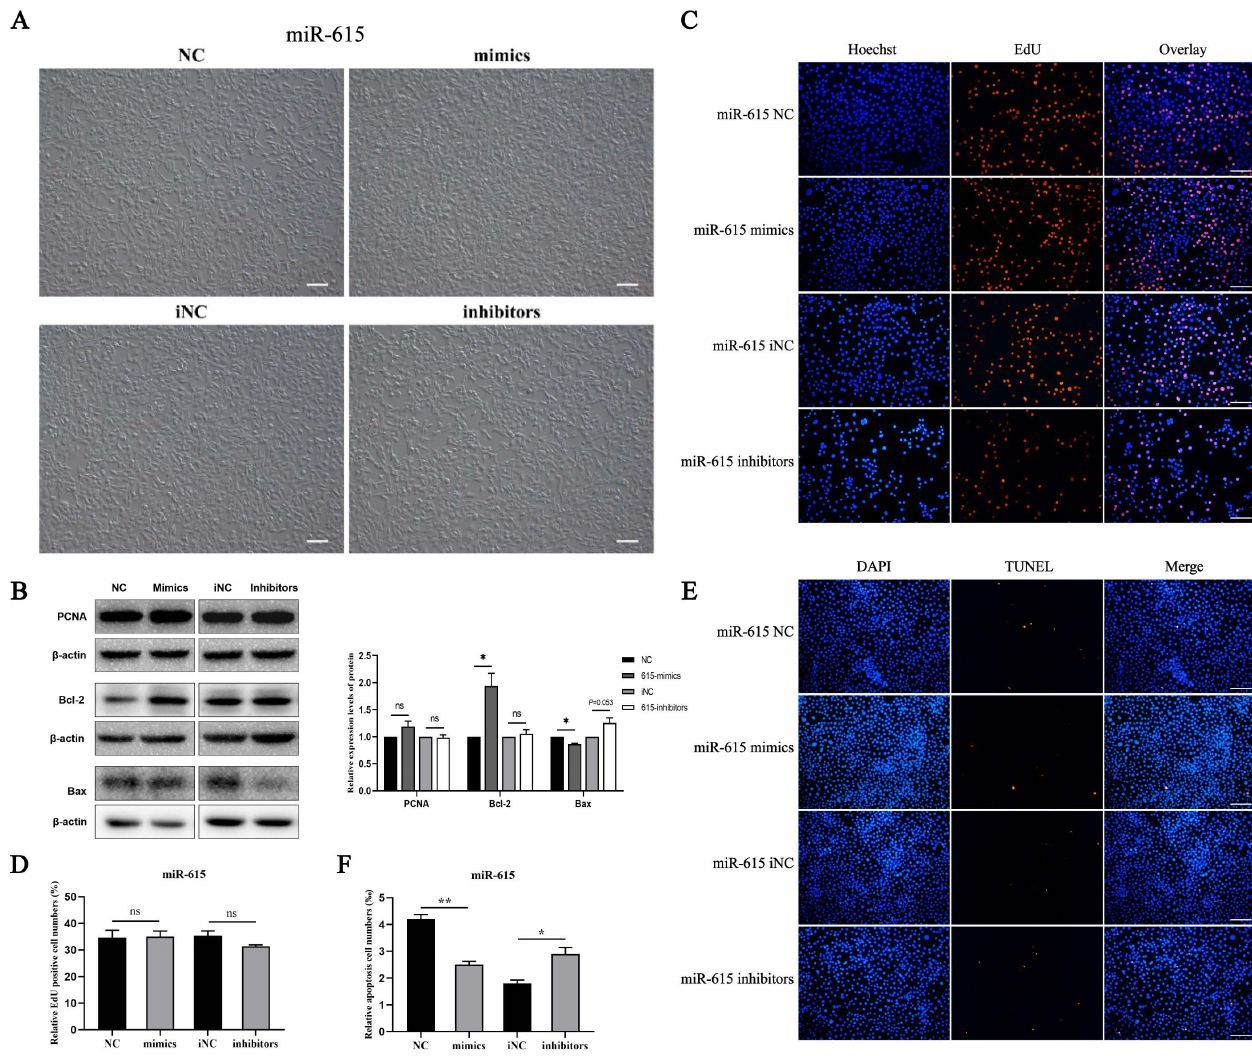
Figure 3. The effects of miR-615 on proliferation and apoptosis in TM3 cells. ( A ) The phenotypes of TM3 cells after over-expressing or inhibiting miR-615. ( B ) Proliferation (PCNA) and apoptosis (Bcl2, Bax)-related protein expression levels were detected after miR-615 treatment for 48 h. ( C , D ) EdU assay was performed after miR-615 transfection for 48 h. ( E , F ) TUNEL assay was performed after miR-615 transfection for 48 h. Bar value is 100 µ m. * Means p < 0.05, ** means p < 0.01, and ns means no significant